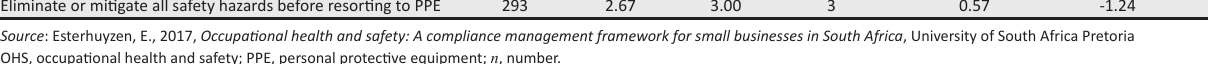
TABLE 7: Descriptive statistics on actual behaviour of small business owners or managers regarding hazards in the workplace. Employer responsibility in terms of the OHS Act